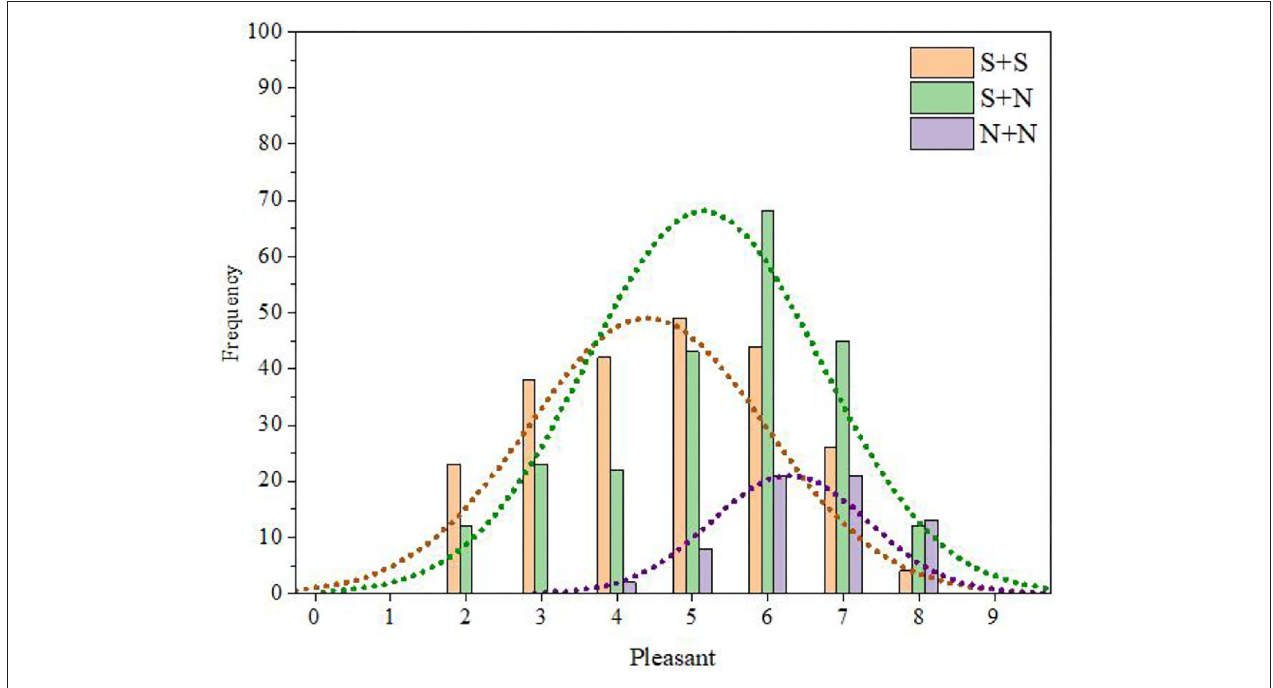
FIGURE 14 | Distribution of statistical histogram of pleasantness category.